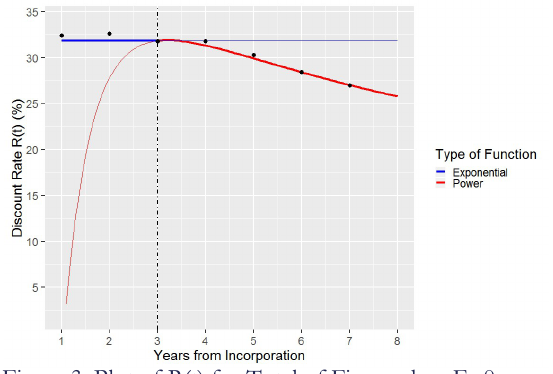
Figure 3: Plot of R(t) for Total of Firms when